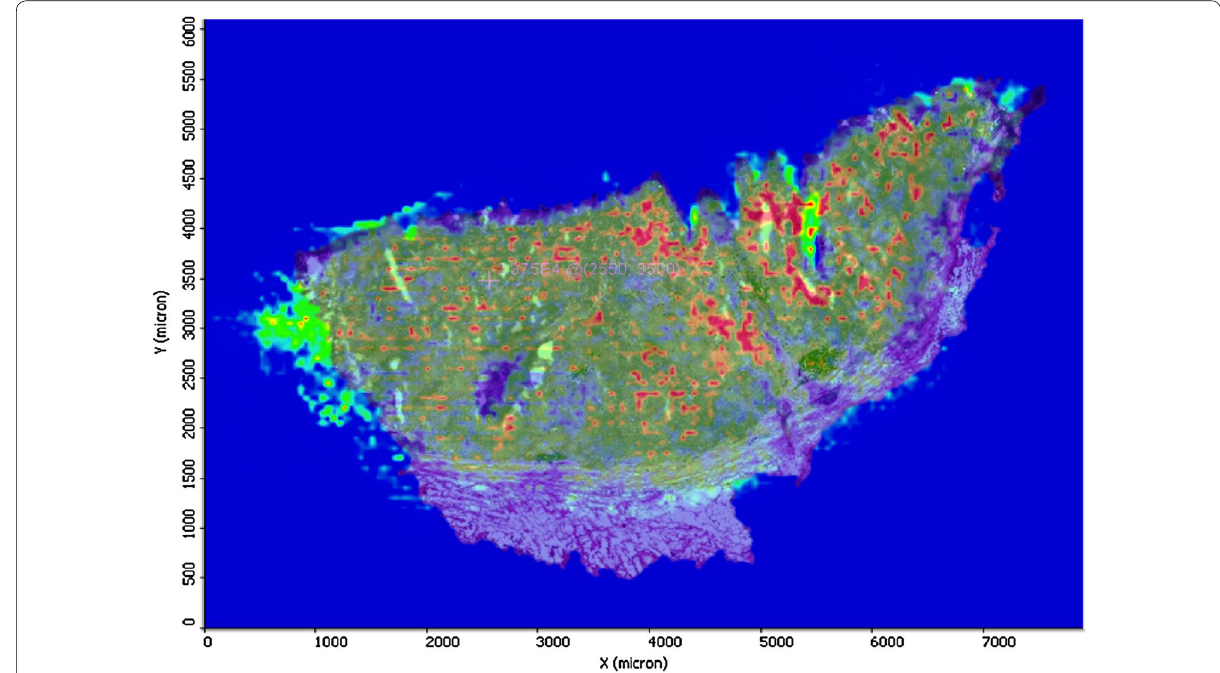
Fig. 8 Counterplot of the MALDI image overlaid with the histology image from cancer patient